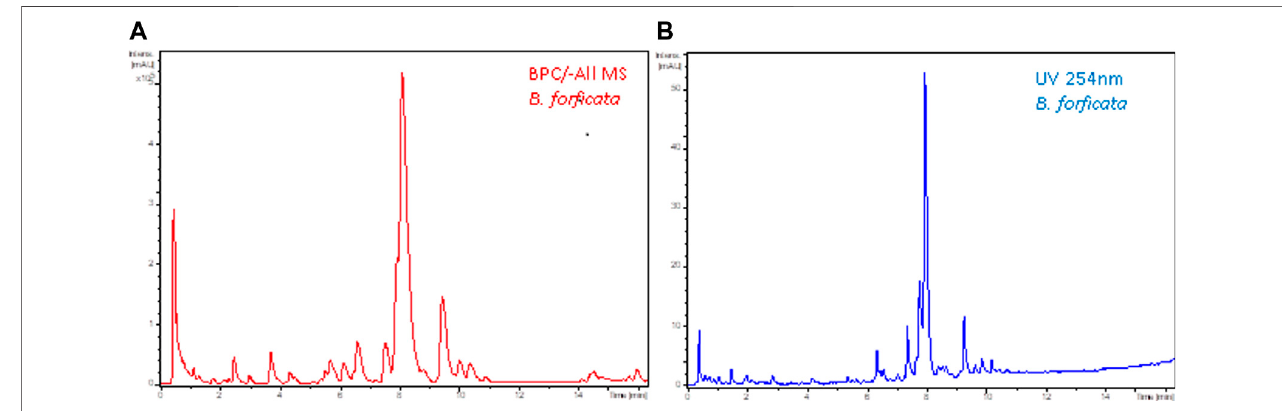
FIGURE3| Finalchromatogram after DoE — Step2ofleafethanolicextract Bauhiniafor fi cata (A) baseionchromatograminthenegative ionizationmode(-All/MS), and (B) by UV at 254 nm. Chromatographic conditions: Kinetex ® Biphenyl column, fl ow rate 0.7 ml/min, temperature 50 ° C. Gradient: 5% – 70% B.